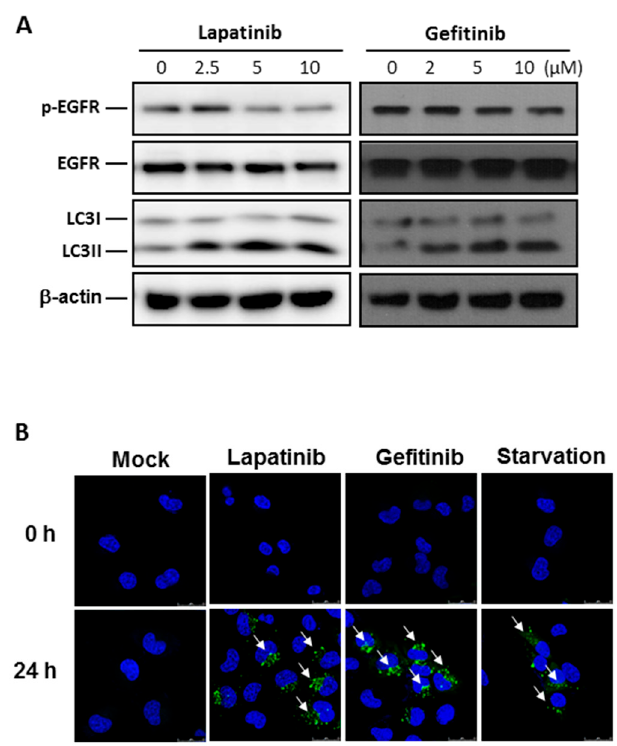
Figure 2. Epithelial growth factor receptor (EGFR) inhibitors significantly induce the autophagy activities in T24 human bladder cancer cells. ( A ) Western blot analysis for evaluating autophagy activation indicated by the expression of LC3I/II following treatment with EGFR inhibitors for 24 h, at different dosages (0, 2.5, 5 and 10 µ M). β -actin was used as a loading control in the Western blot analysis; ( B ) confocal microscopic analysis of autophagy activation by the evaluation of green fluorescent protein (GFP) expression in LC3-GFP-expressing T24 cells after treatment of 5 µ M EGFR inhibitors for 24 h. Cells cultured in serum-starvation conditions for 24 h were used as positive controls for autophagy activation analyses. White arrows indicate the LC3 autophagic puncta.